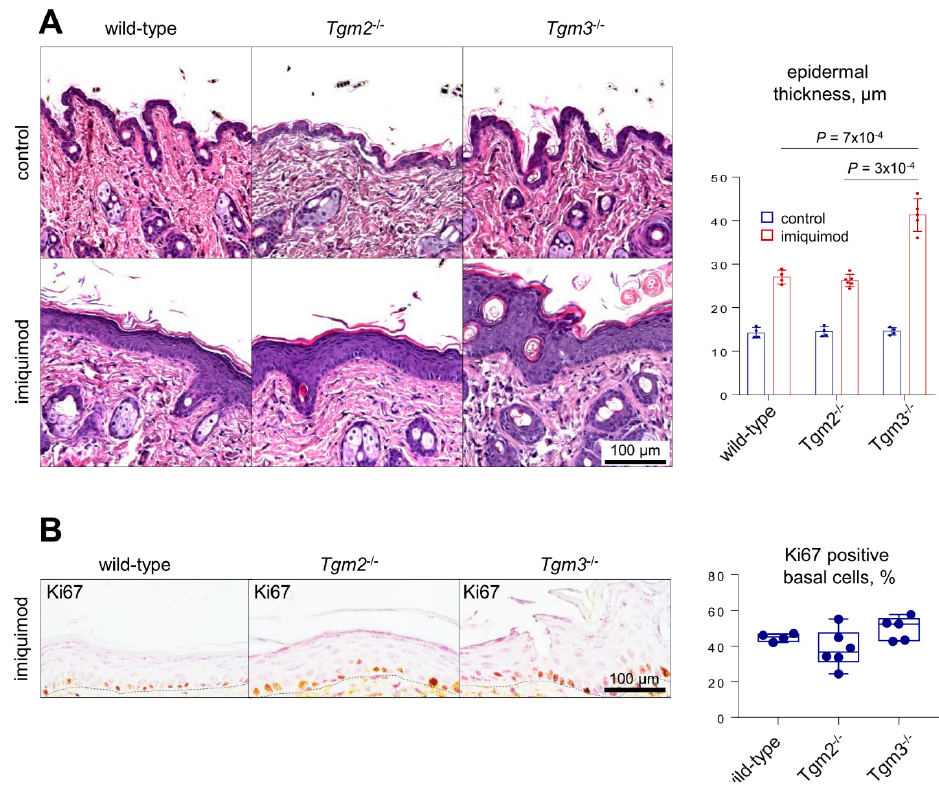
Figure 3. Loss of TG3 leads to epidermal thickening upon imiquimod treatment. Scale bar 100 µ M. (A) H&E staining of the skin of either control or imiquimod-treated WT, TG2KO, and TG3KO mice. The graph shows the measurement of epidermal thickness. (B) Immunohistochemical staining for Ki67 in the skin of imiquimod-treated WT, TG2KO, and TG3KO mice. The graph shows the quantification of the percentage of Ki67-positive basal cells.